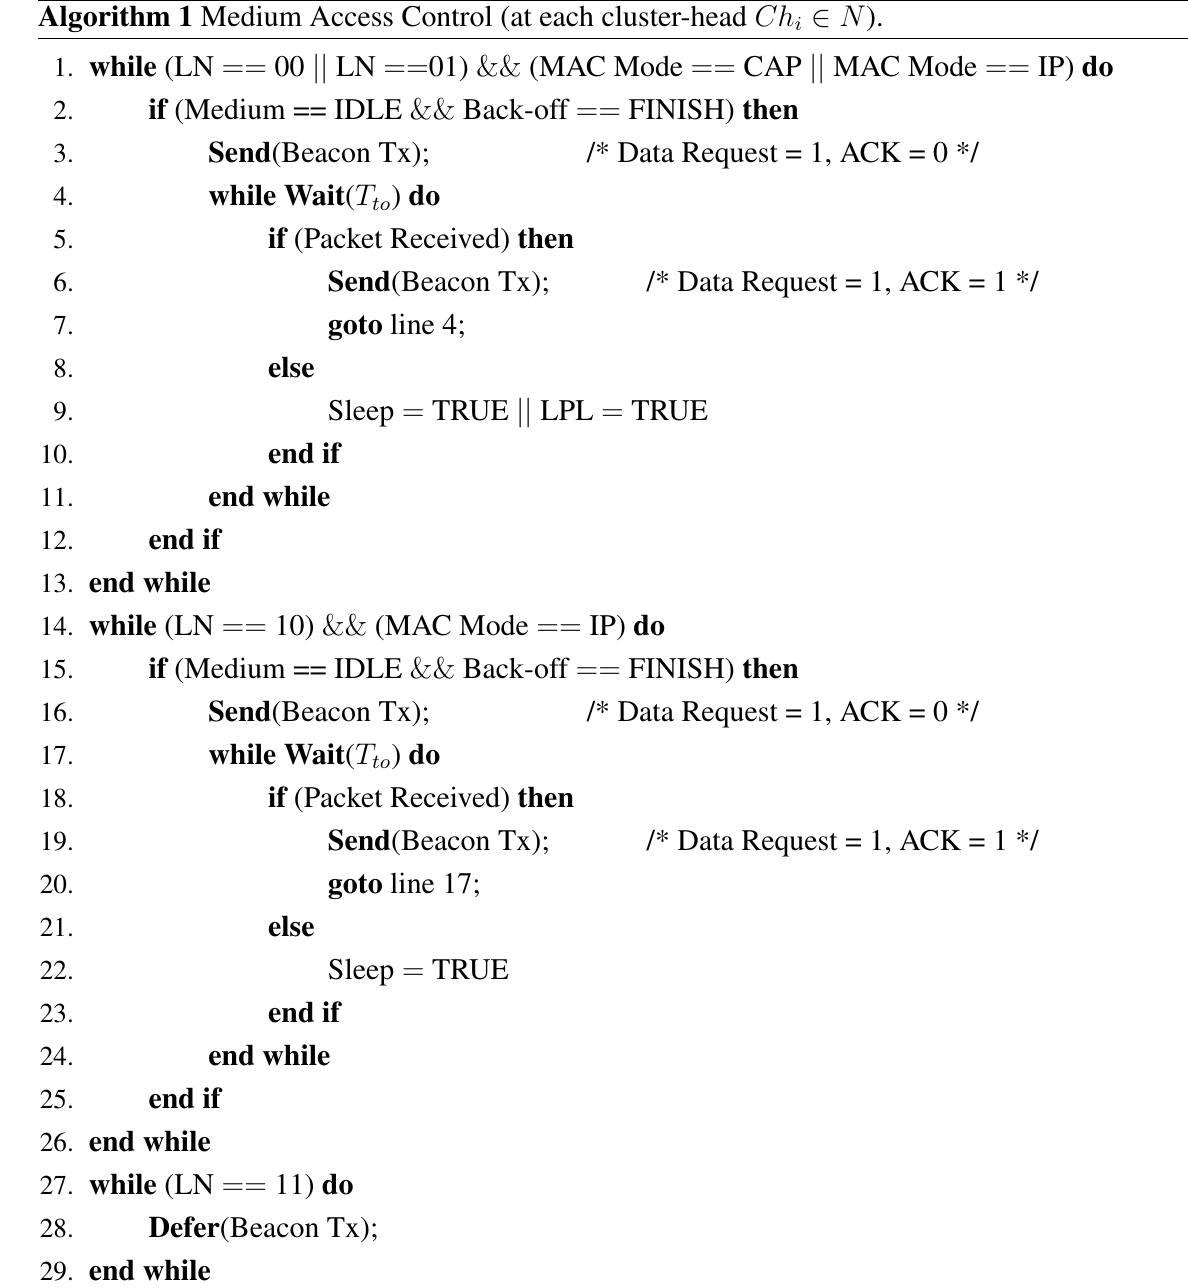
Algorithm 1 Medium Access Control (at each cluster-head Ch